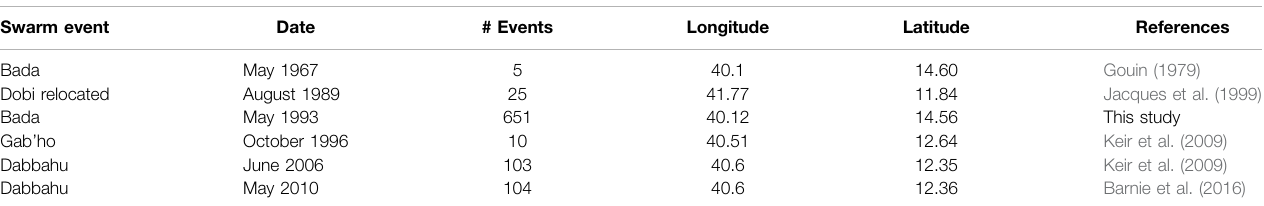
TABLE 1 | List of swarms complementing the ISC